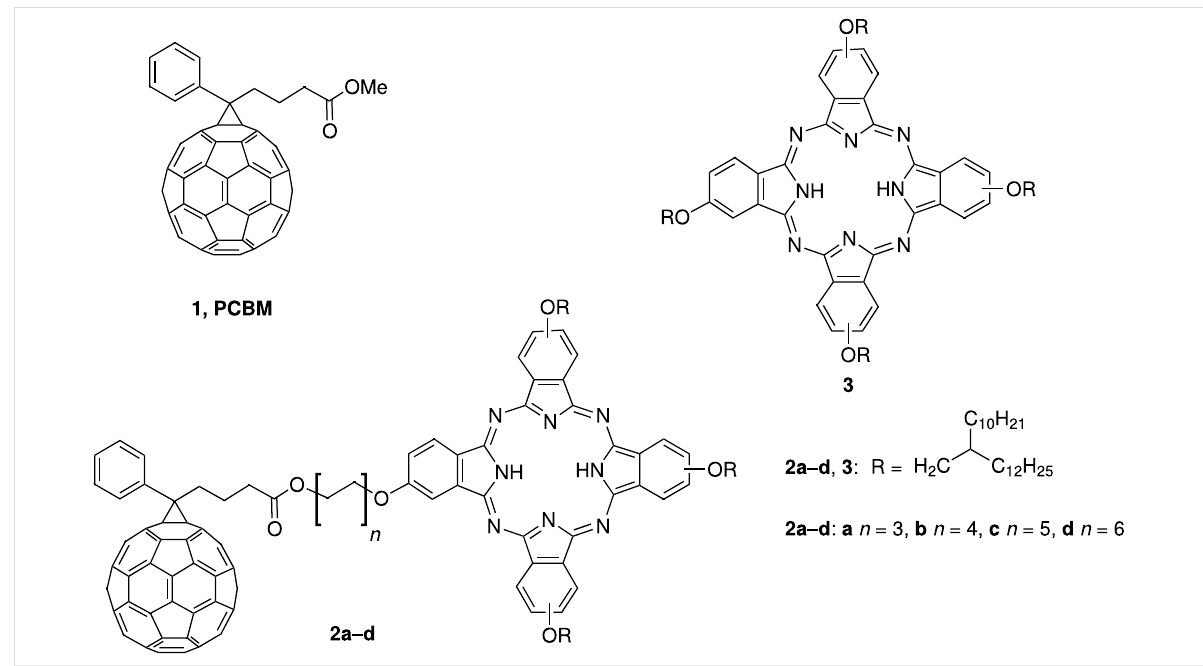
Figure 1: Phthalocyanine-C 60 dyads 2a–d described in this paper, C 60 -derivative 1 (PCBM) and previously reported mesogenic phthalocyanine 3